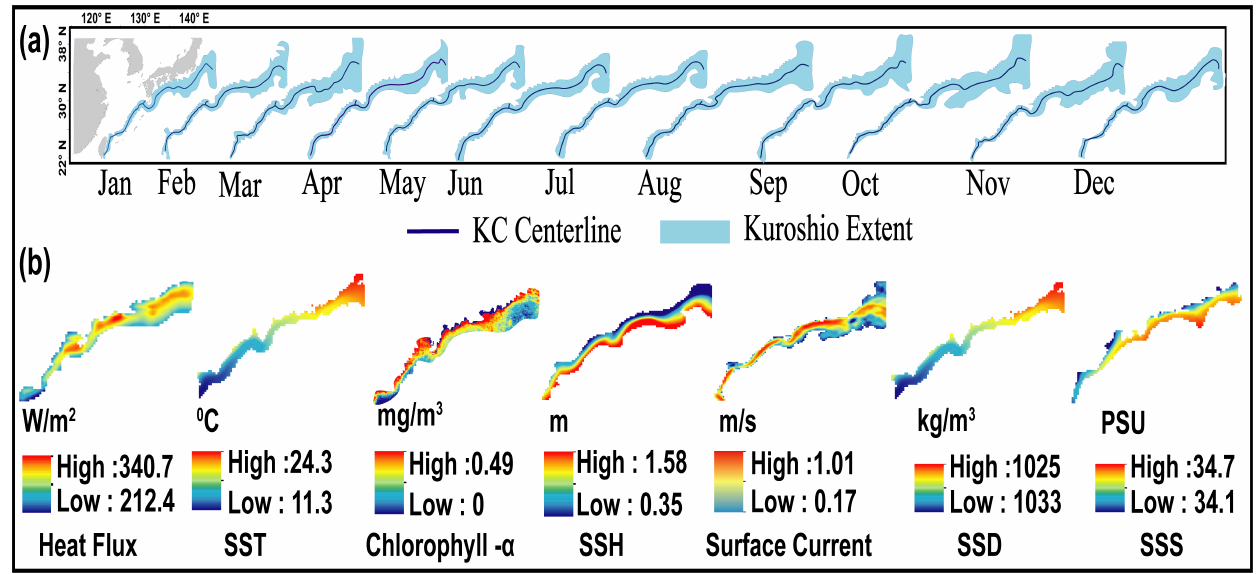
Figure 8. The climatological monthly dispersal ( a ) sea surface current data with Kuroshio extent and its centerline (1993–2018); ( b ) the Kuroshio extent from their respective parameters.